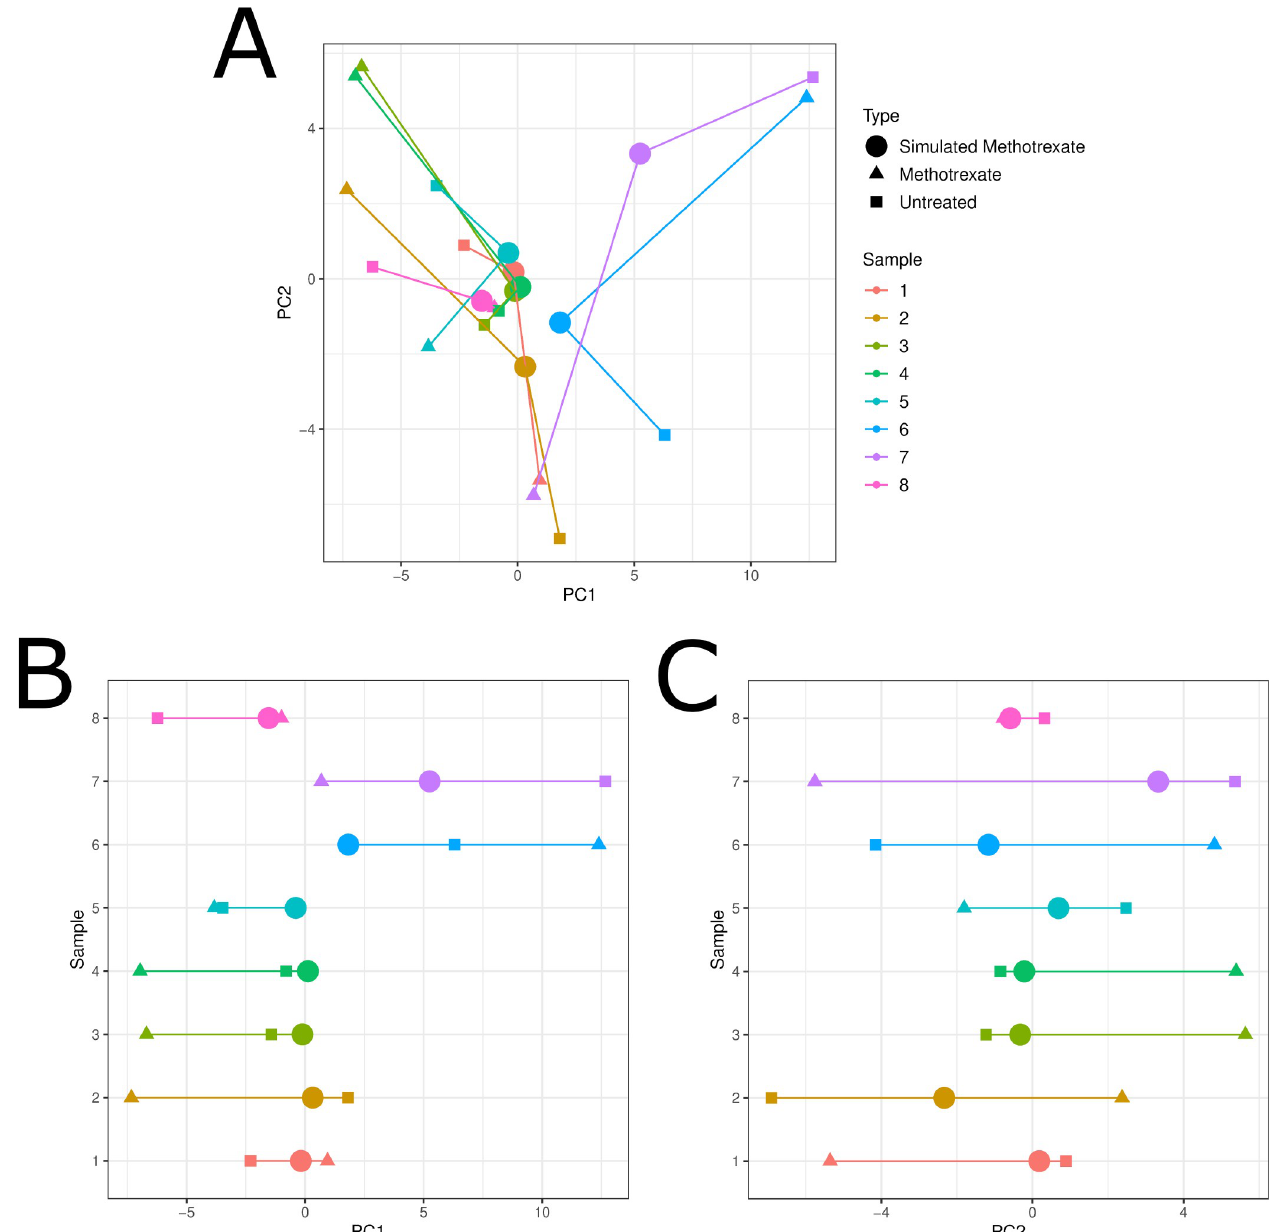
Fig 4. (A) PCA showing untreated, methotrexate treated, and simulated methotrexate treated samples generated by NetPTP for samples in GSE45867. Samples were further visualized along PC1 (B) and PC2 (C) separately, showing that simulated methotrexate samples are located between untreated and measured methotrexate samples along PC2. Our method seems conservative in that the simulated treatment samples tend to remain closer to the untreated samples as compared to the treated